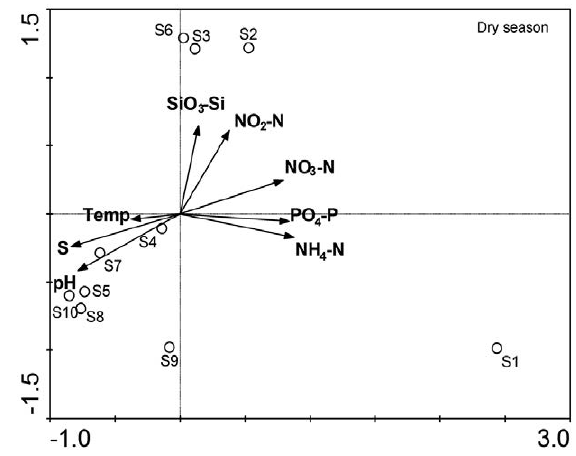
Fig. 6. – Canonical correspondence analysis ordination diagram of cyanobacterial communities in the dry season and wet season asso- ciated with environmental variables of silicate (SiO